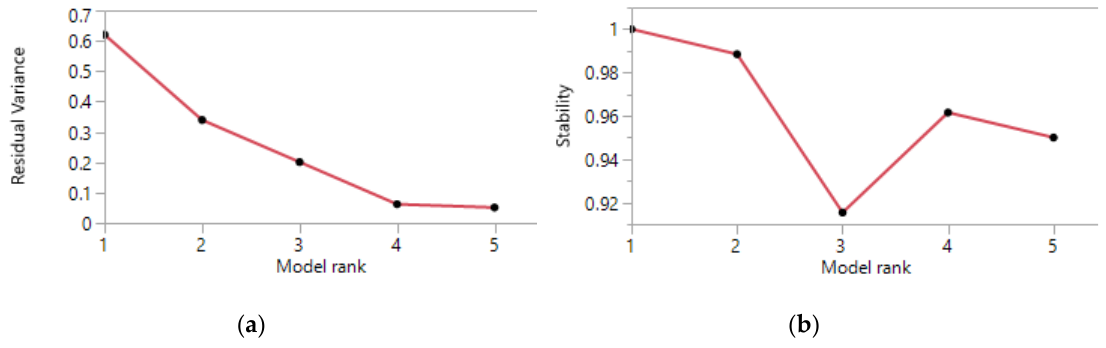
Figure 1. ( a ) Residual sum of squares; ( b ) Row clustering stability.